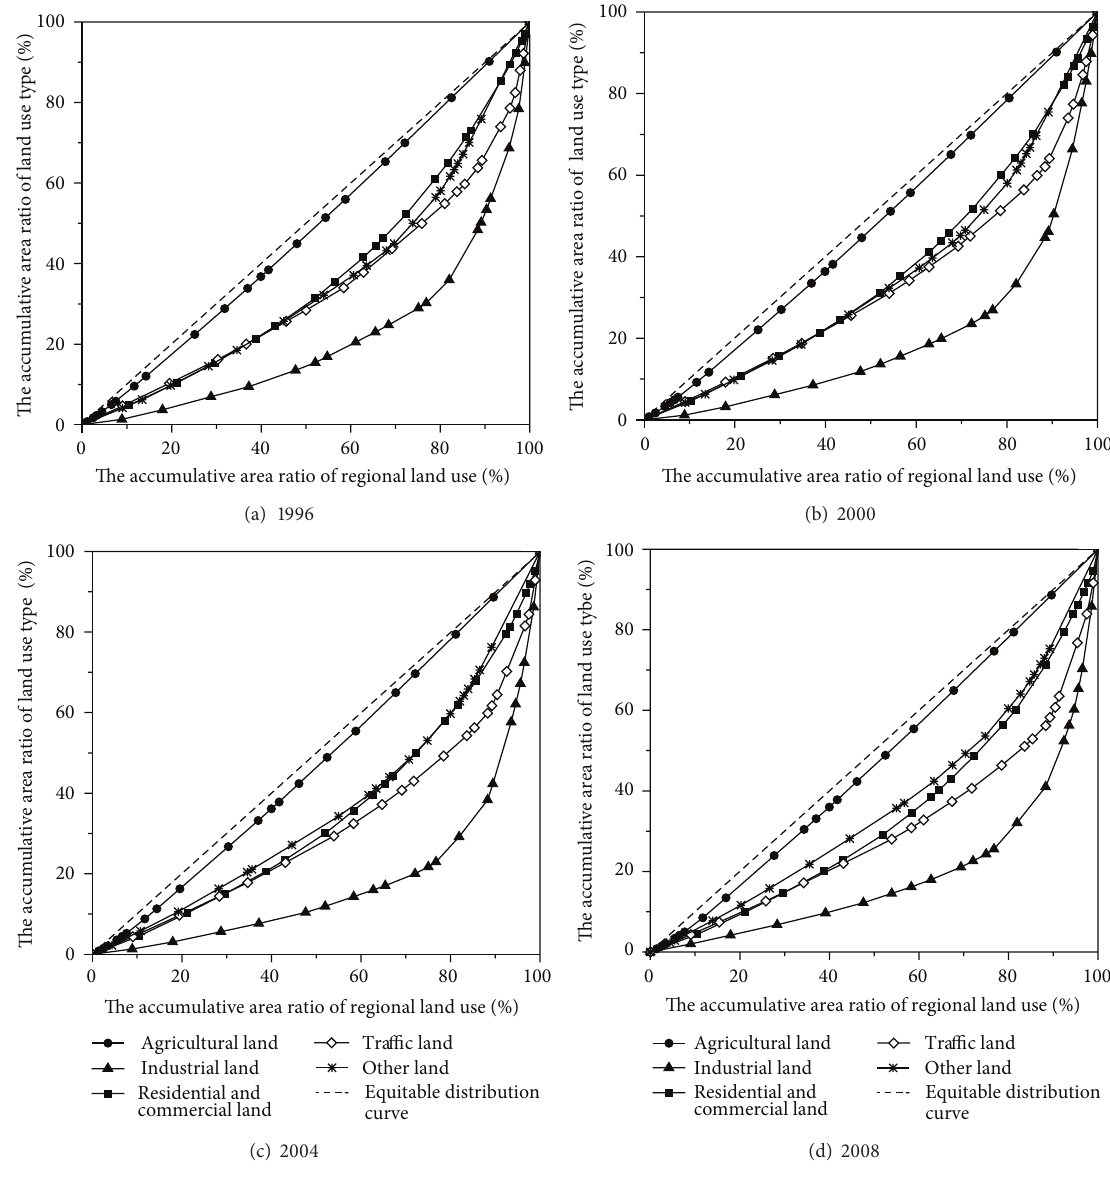
Figure 4: Spatial Lorenz curves of different land use